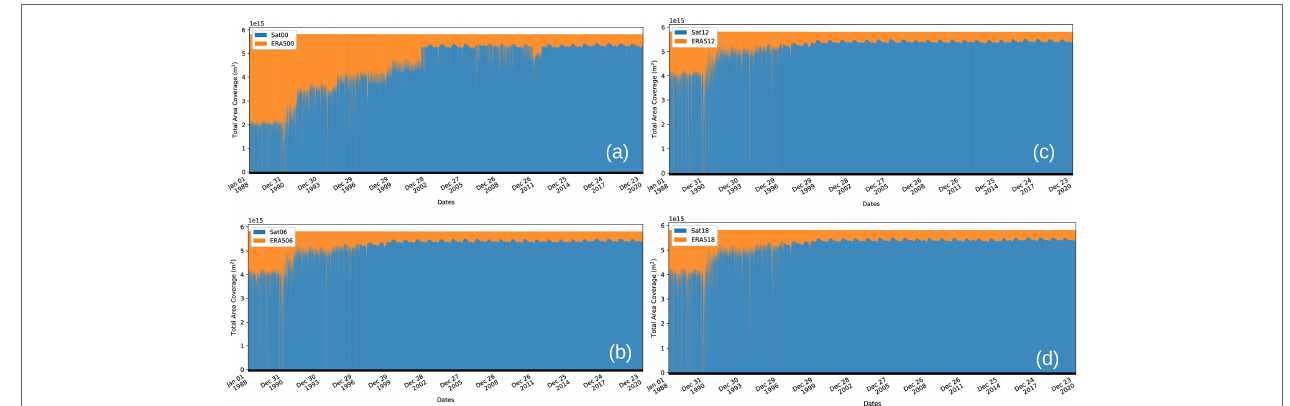
FIGURE 4 | Time series plots of total area coverage for satellite data (in blue) and reanalysis data (in orange) for the period of NBS v2.0. at four different synoptic times (A) 0000 UTC, (B) 0600 UTC, (D) 1200 UTC, and (C) 1800 UTC.